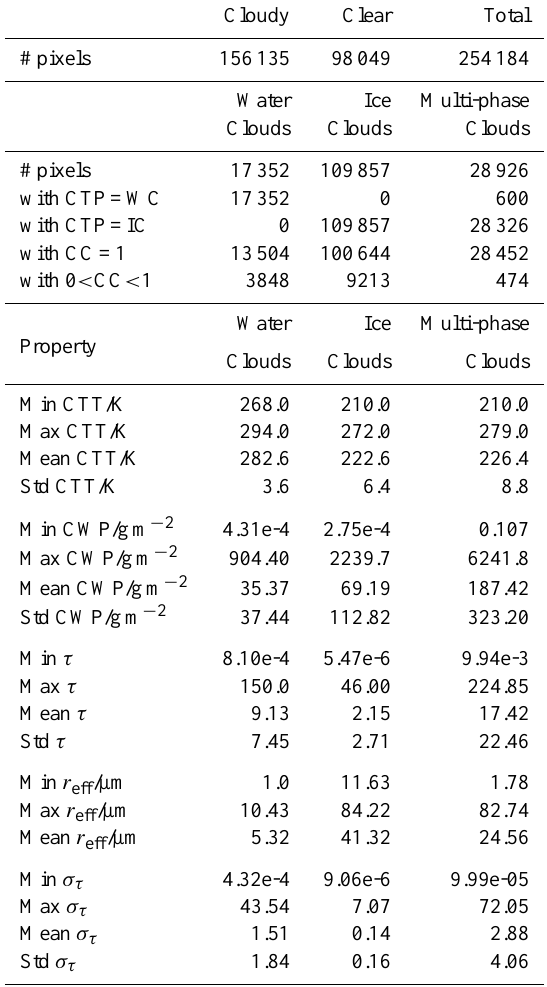
Table 2. Summary of real cloud properties after projection to the MET-8/SEVIRI grid. CTP=Cloud Top Phase, WC=Water Cloud, IC=Ice Cloud, CC=Cloud Cover, CTT=Cloud Top Temperature, CWP=Cloud Water Path, τ =Optical Thickness, r eff =Effective Radius, σ τ =Standard Deviation of Optical Thickness inside every single pixel.